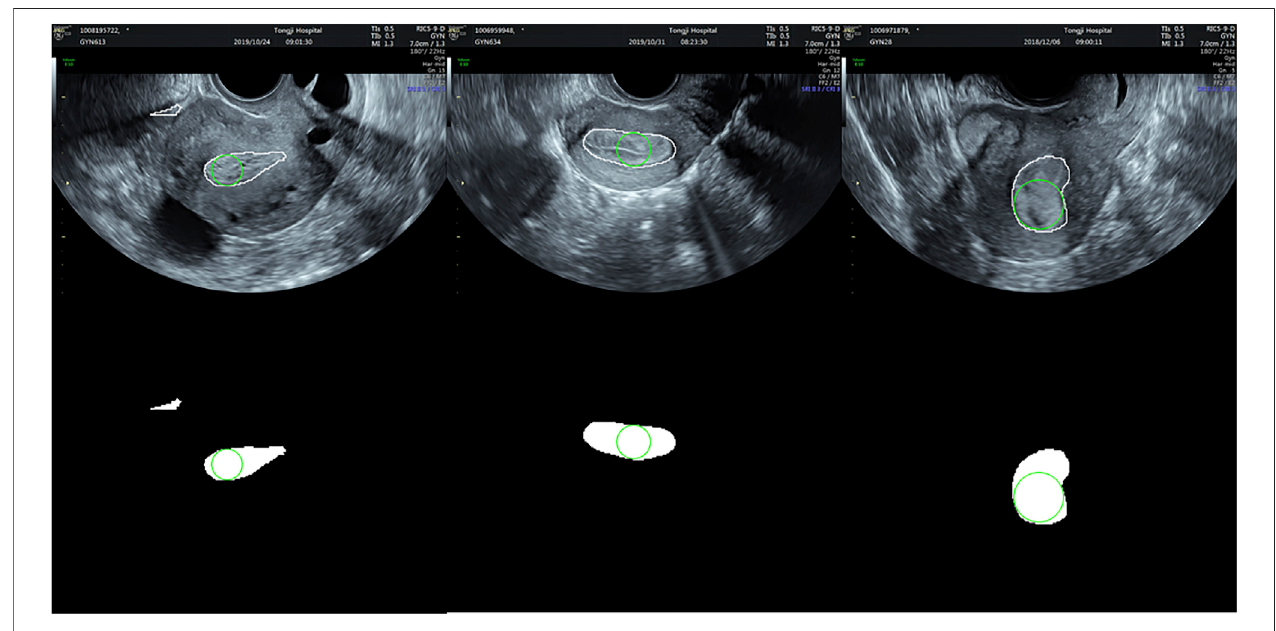
FIGURE 8 | The largest inscribed circles in three segmented mask images.